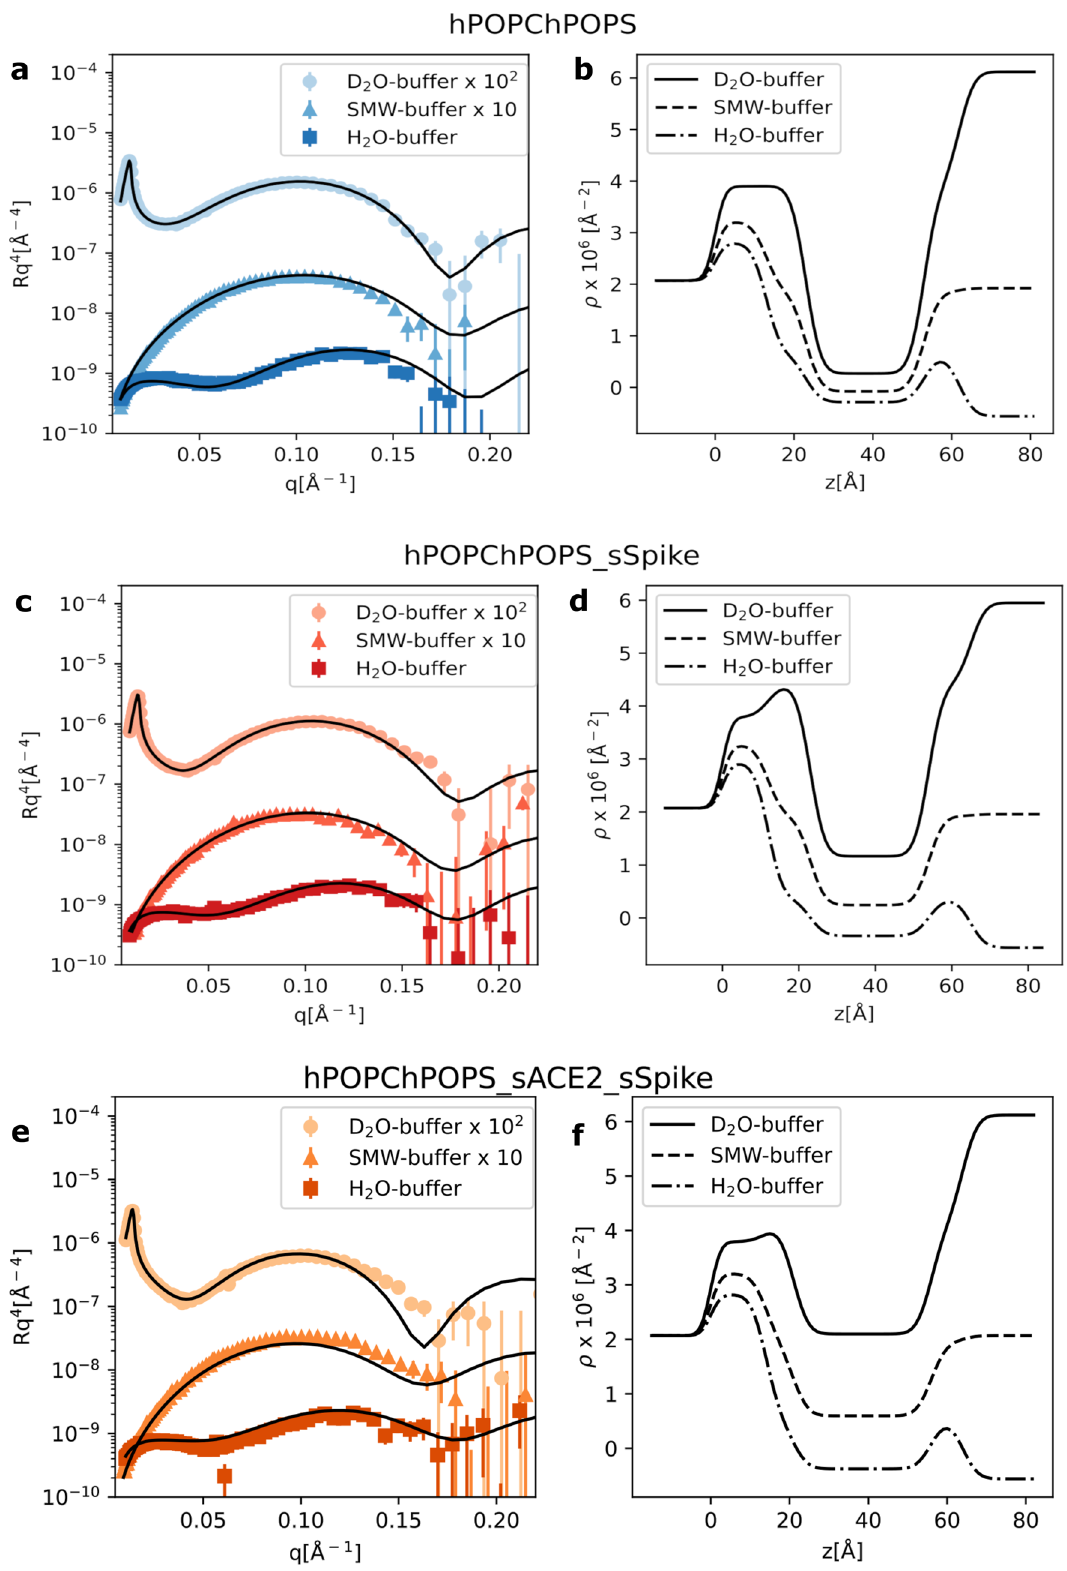
Figure 1. NR experimental data together with the fitting curves from a hPOPC/hPOPS lipid bilayer ( a ) before, ( c ) after injection of the sSpike solution, ( e ) after sequential injection of sACE2 and sSPike, and ( b , d , e ) corresponding scattering length density profiles calculated from NR data analysis. Data and fits are scaled for clarity as reported in the